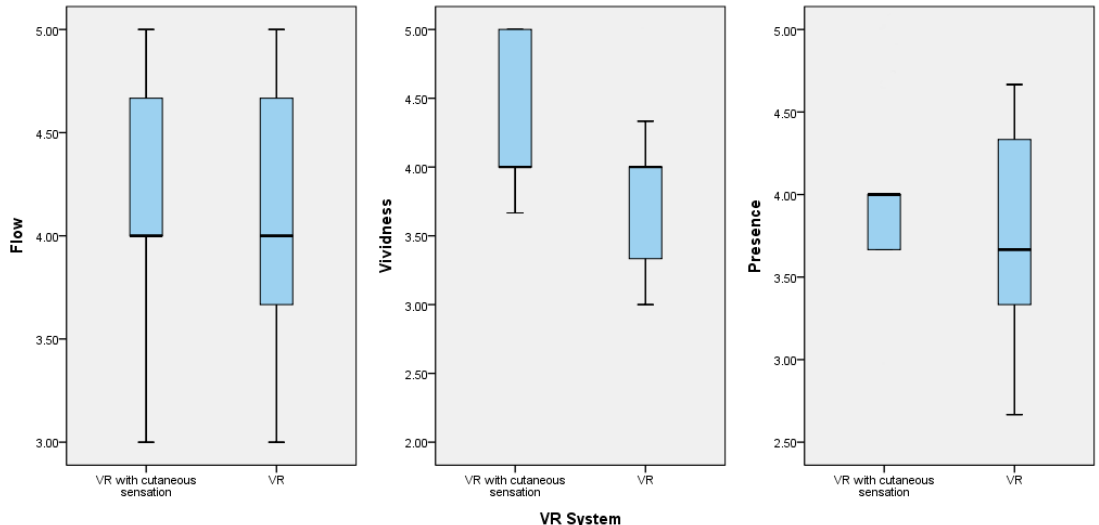
Figure 6. Comparison of the boxplots for the flow, vividness, and presence variables of the low-anxiety group while playing the fire safety education VR game with cutaneous sensation and the group that played the basic fire safety education VR game.